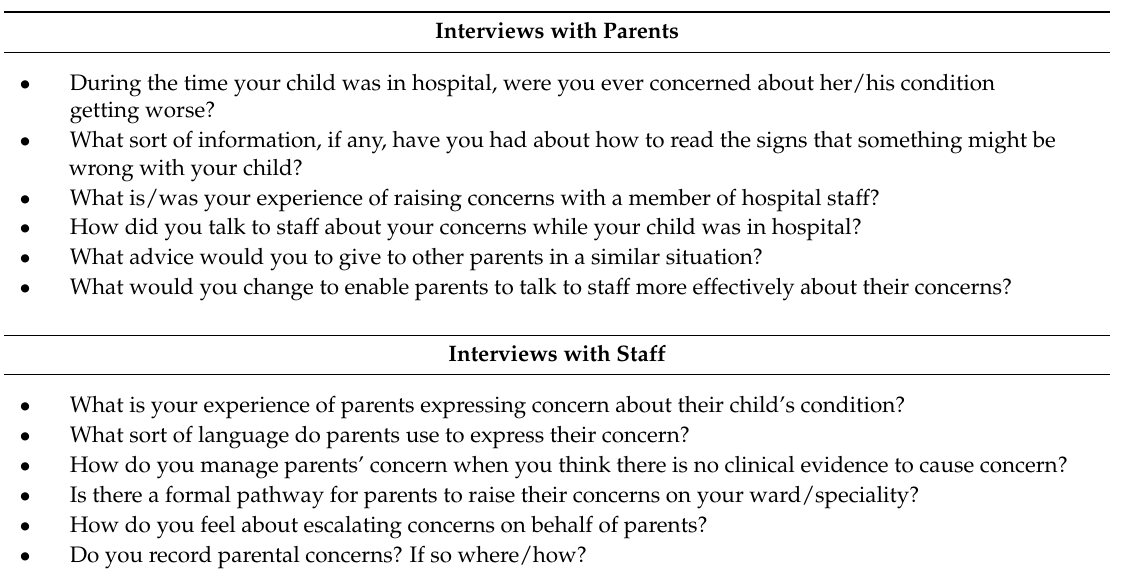
Table 1. Semi-structured interview